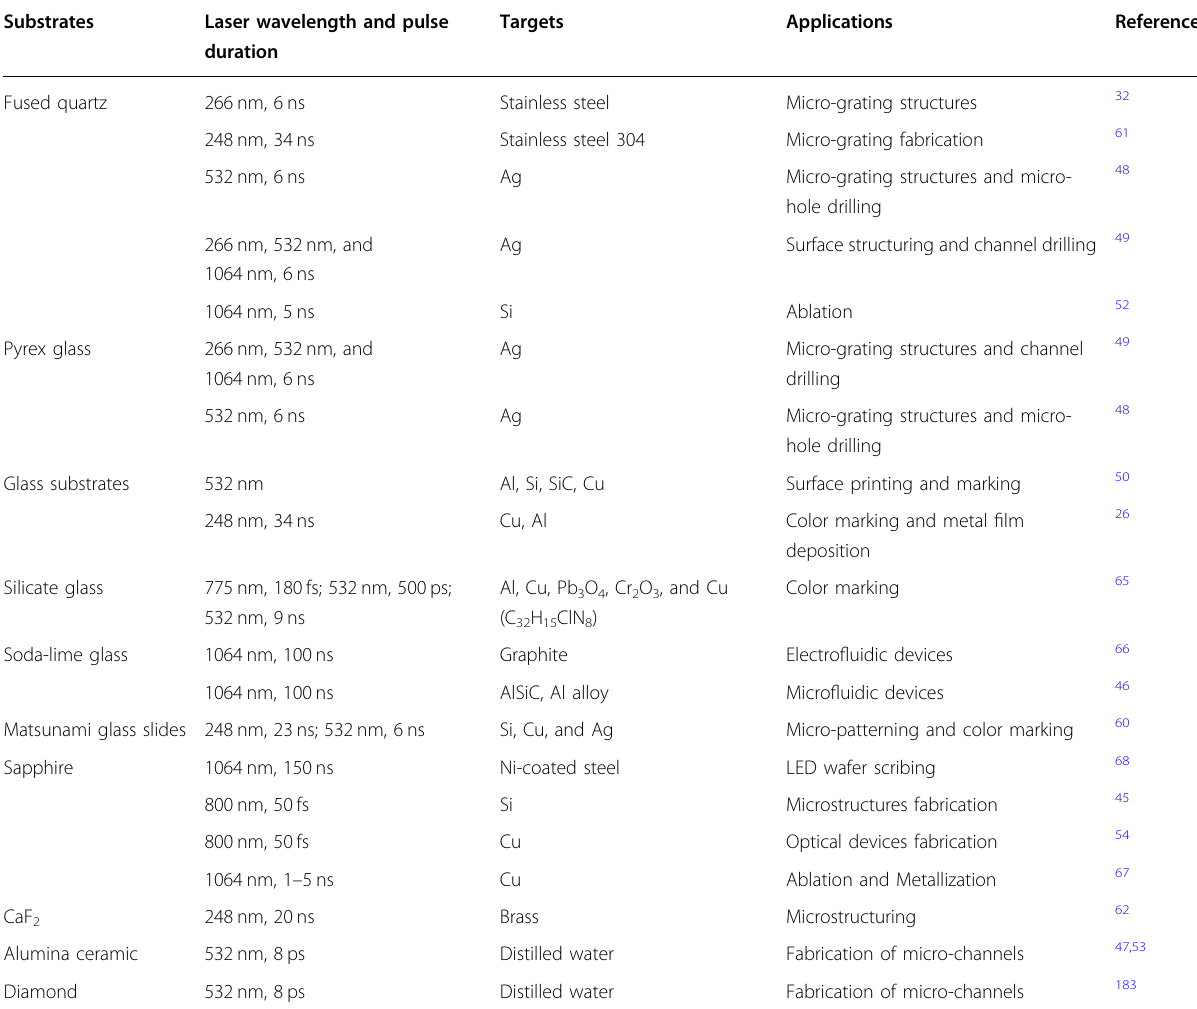
.Table 1 Summary of LIPAA studies on different transparent hard materials